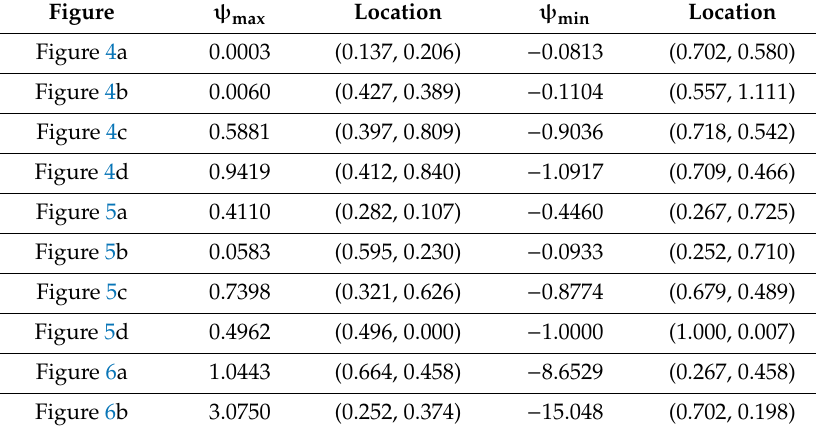
Table 1. Optimal values of stream function along with its location in the cavity.